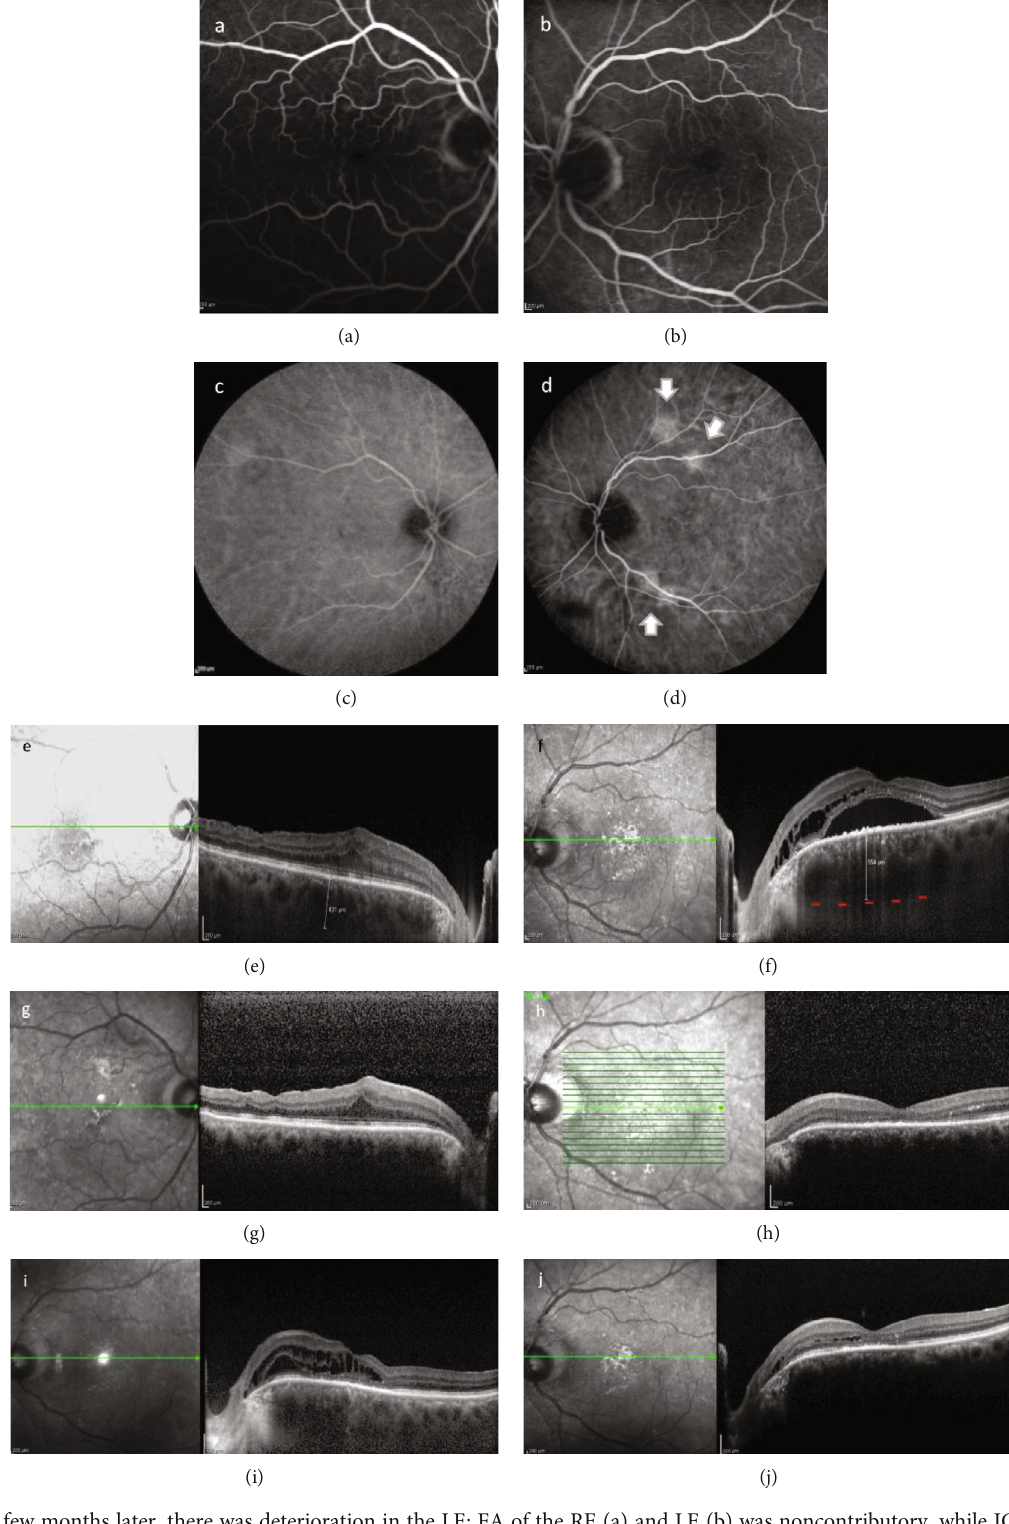
Figure 2: A few months later, there was deterioration in the LE: FA of the RE (a) and LE (b) was noncontributory, while ICGA (c and d) showed hyper fl uorescence in 4 foci during the late phase of the exam in the LE corresponding to areas of choroidal hyperpermeability (white arrows, (d)). EDI-OCT revealed increased choroidal thickness [max thickness: 431 μ m in the RE (e) and 554 μ m in the LE (f)], with pachyvessels ( LE > RE ) located mostly nasally to the fovea and IRF/SRF accumulation in the fovea of the LE (f). OCT images of RE (g) and LE (h) after PDT treatment in LE, showing resolution of CME and SRF in LE. CME observed in the LE 6 months later (i), and fl uid absorption after treatment with dexamethasone drops in the LE